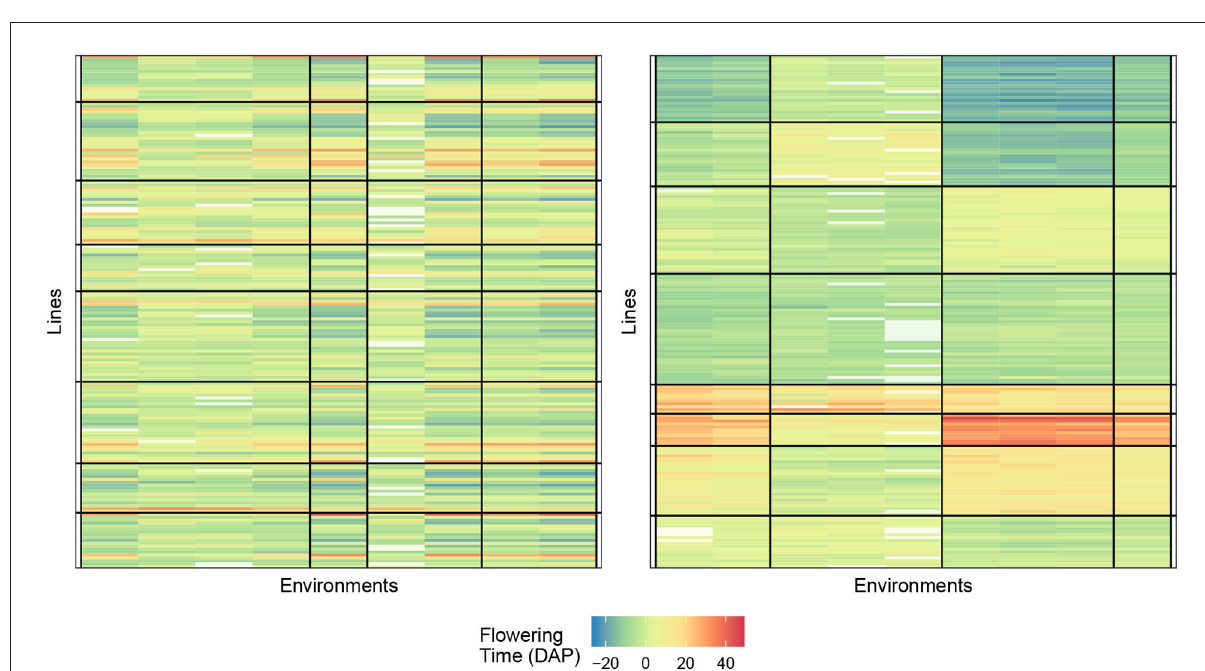
FIGURE6 Biclustering illustration of response (4) with initialization (left) and final bicluster (right) for eight rows and four column clusters (rice data). The homogeneity of the cells indicates that the biclustering algorithm was able to successfully group the response variables in distinct